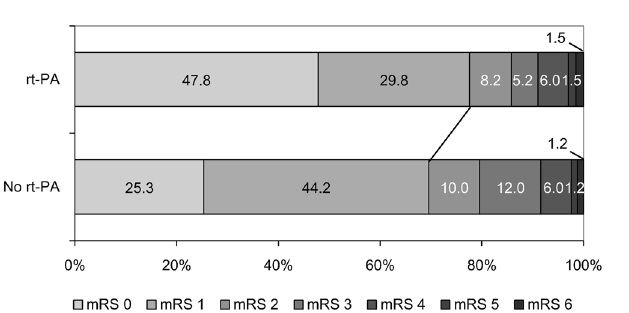
Figure 2. Distribution of mRS scores at 3 months in matched patients with mild stroke with and without rt-PA treatment. mRS: modified Rankin Scale; rt-PA: recombinant tissue plasminogen activator.